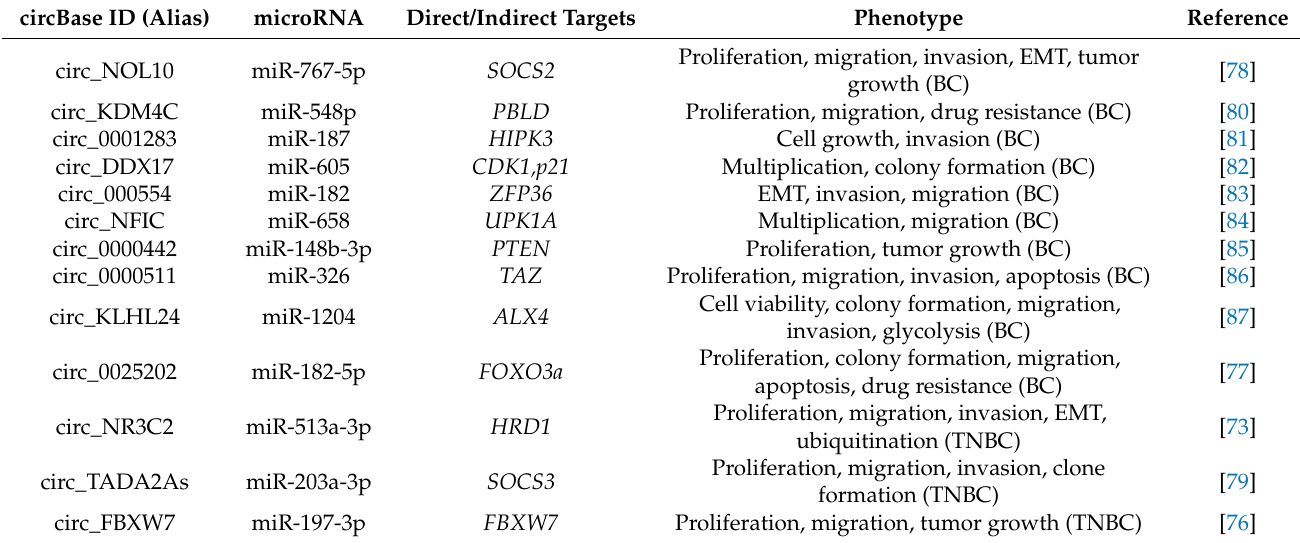
Table 2. The sponge functions of tumor-suppressor circRNA in BC and